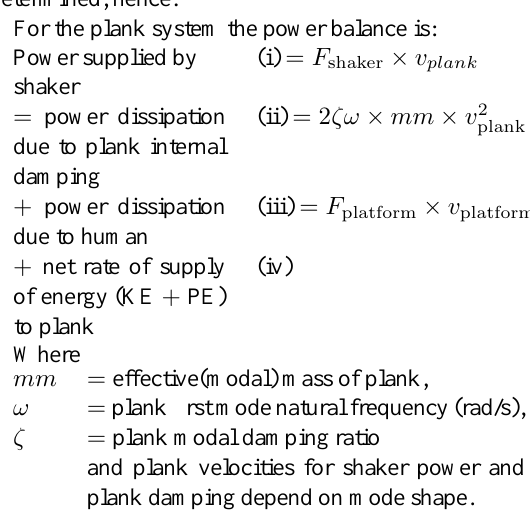
Fig. 3. Schematic of test arrangement. Velocities v plank and v platform were obtained from accelerations a plank and a platform using Simulink 1/s